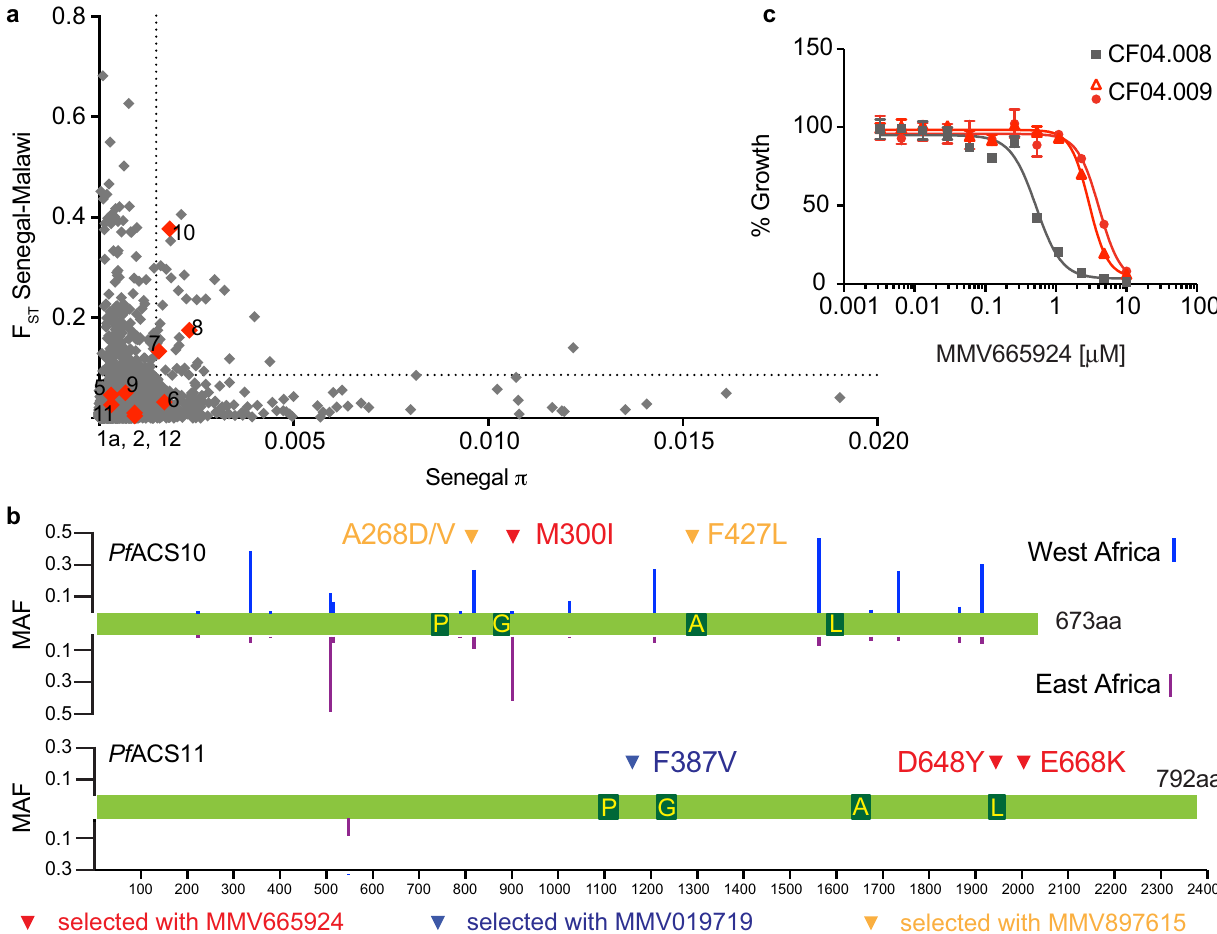
represents the local MAF of each variant in West (blue) or East (purple) Africa. The selected variants are indicated by red, blue, and yellow arrows. Dark green boxes indicate the ACS motifs:P: P-loop, G: Gate motif, A:Adenine binding site, L: Linker. c Representative dose-response assay for a clonal line of CF04.008 (ACS10 M300, gray) and two clonal lines of CF04.009 (ACS10 M300I, red) from Malawi. Assays were run in triplicate and repeated twice. Shown are the average ±SD and the non- linearregression curve fi t for one biological assayrun in triplicate. Source data are provided as a Source Data fi le. MAF minor allele frequency, π pairwise nucleotide diversity within each country, F ST